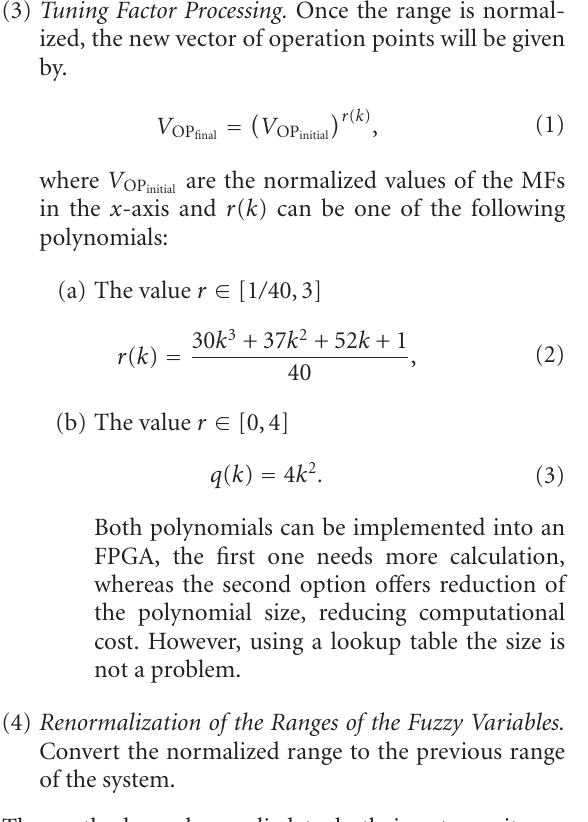
Figure 10: Modifying the input MFs using the formula V OP ( V OP ) r ( k ) initial